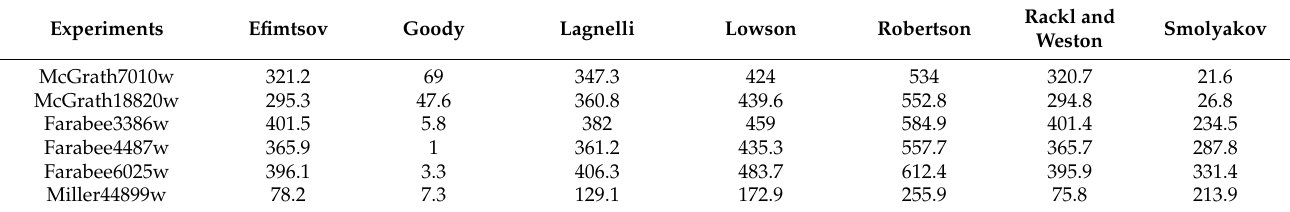
Table A4. Spectrum mean squared error for the low frequency range.